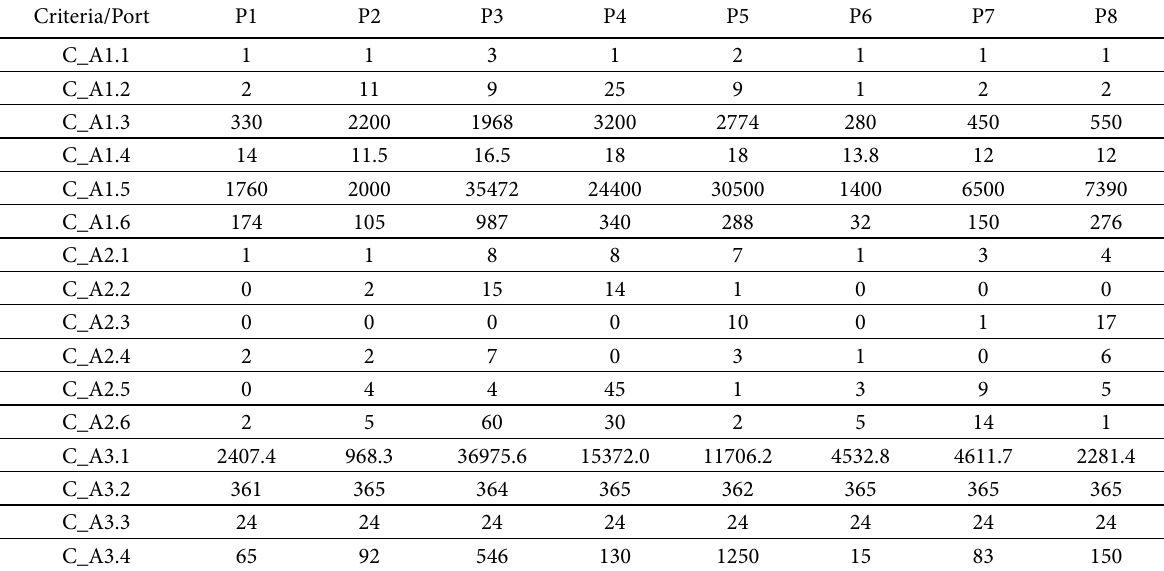
Table 2. Quantitative criteria (A): sub-criteria sets A1, A2, and A3